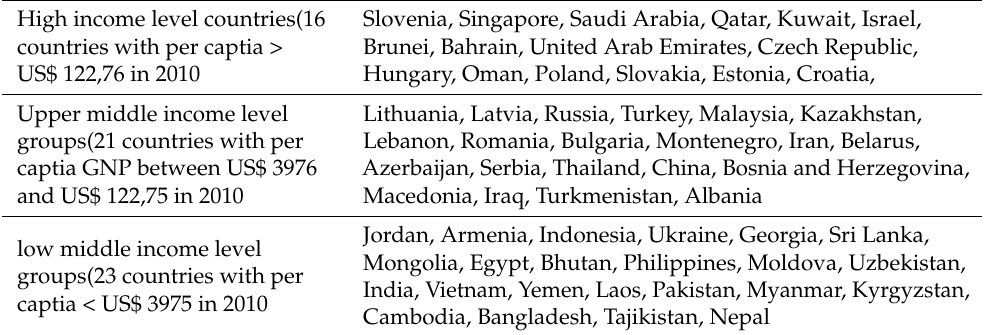
Table A1. List of 60 B&R countries and